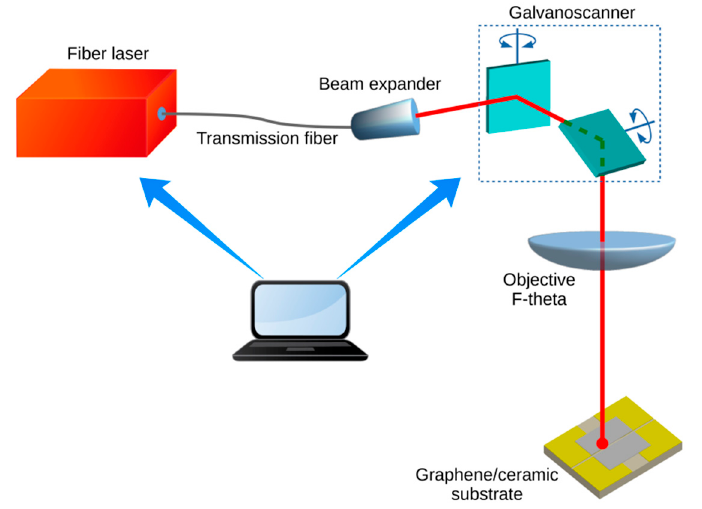
Figure 1. Laser patterning system.